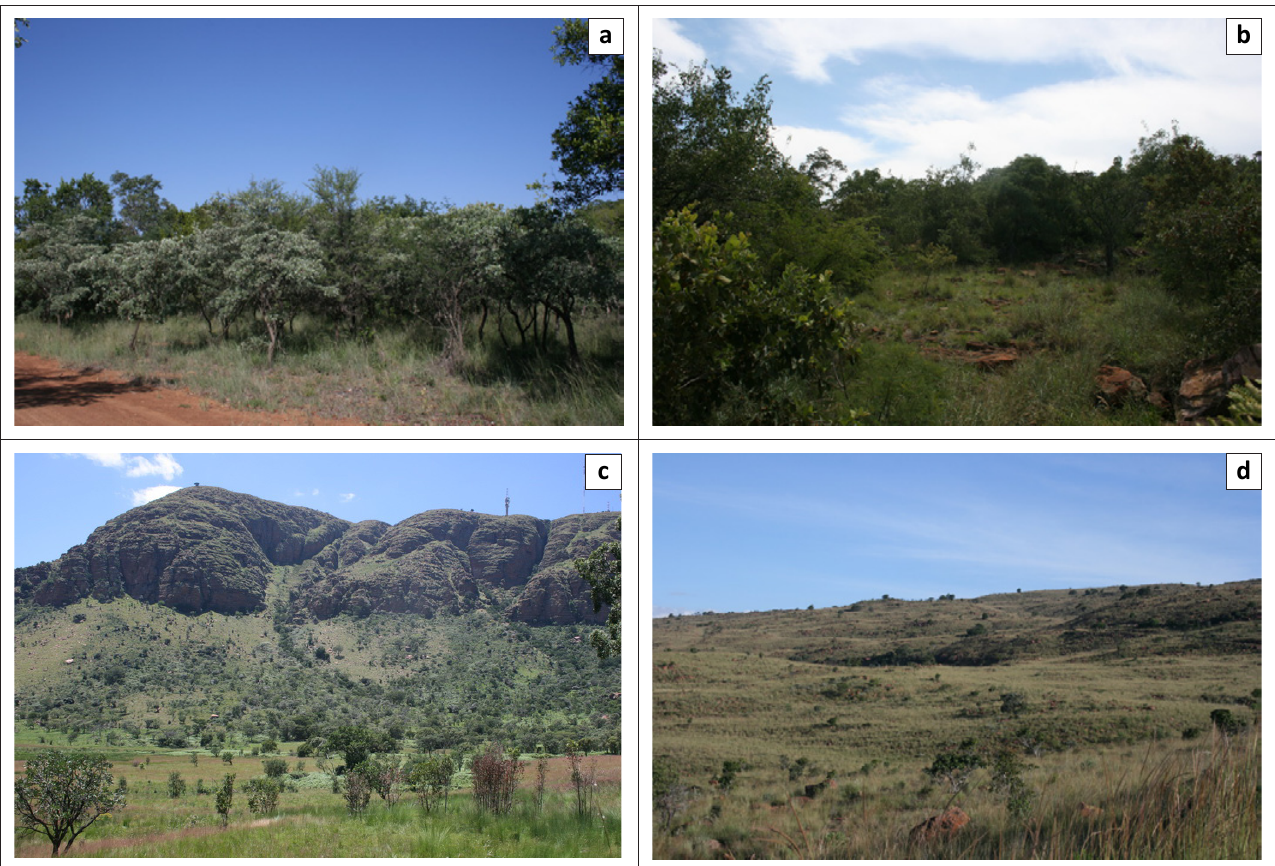
FIGURE 2: Vegetation type at the four sampling sites. (a) M1, Western Sandy Bushveld; (b) M2, Waterberg Mountain Bushveld; (c) M3, ecotone on Waterberg–Magalies Summit Sourveld and Waterberg Mountain Bushveld; (d) M4, Waterberg–Magalies Summit Sourveld.